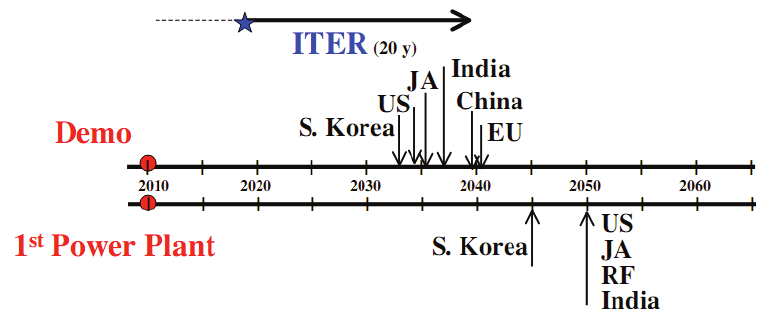
Figure 10. Projection of Demo and first power plant